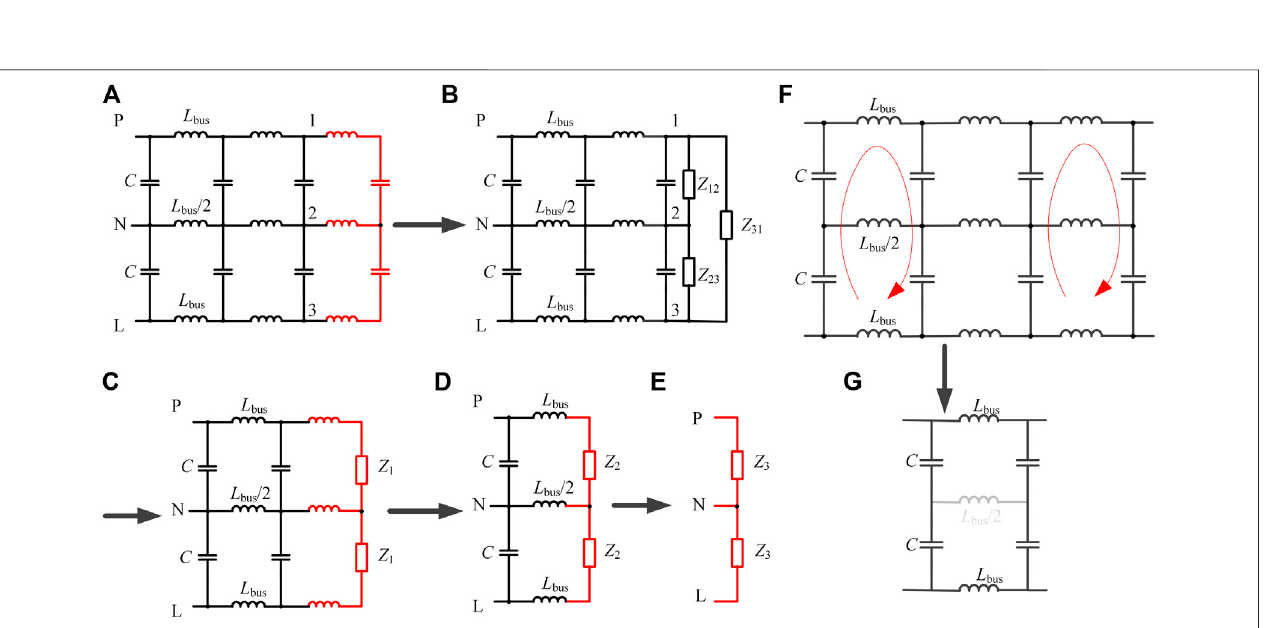
Frontiers in Energy Research |